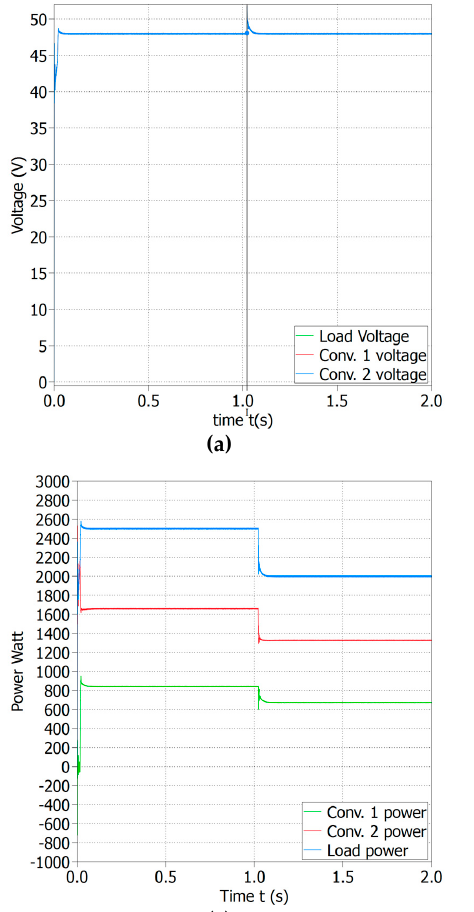
Figure 8. Scenario 2 outputs with load resistance of 0.9216 Ω , K 1 = 1 and K 2 = 2, Rline1 = Rline2 = 0.0001 Ω , τ ds = 5 ms, ( a ) Converters’ output voltages and the load voltage, ( b ) Converters’ output currents and the load current, ( c ) Converters’ output power and the load power, ( d ) Circulating